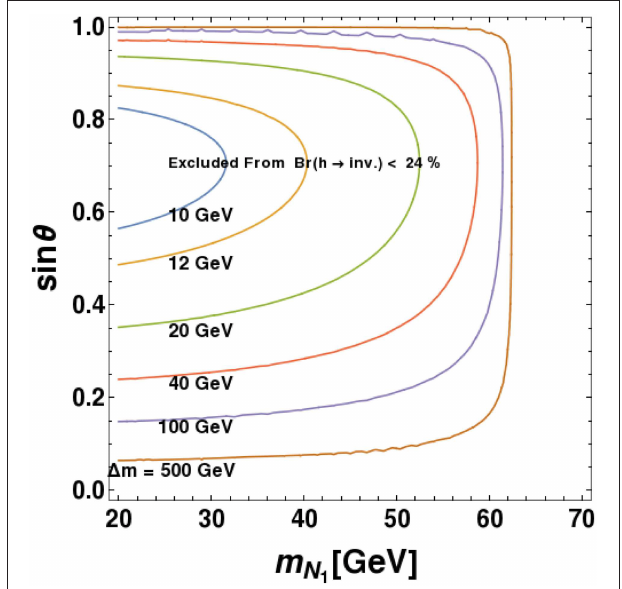
FIGURE 14 | Constraints from Higgs invisible decay width is shown in sin θ plane. Here each contour line correspond to different value of 1 m m N 1 − depicted in the figure. Inner region of each contour line excluded from